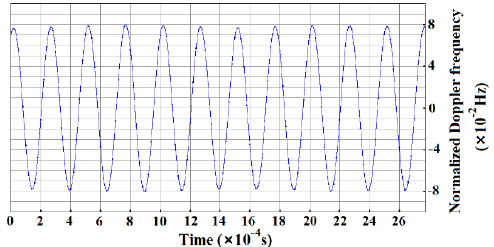
Figure 4. Time–frequency analysis of the homodyne LDV output.